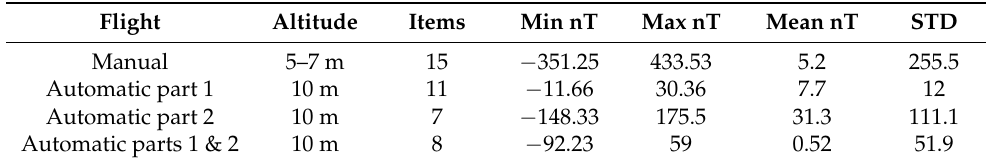
Table 1. Statistics at crossing points for each